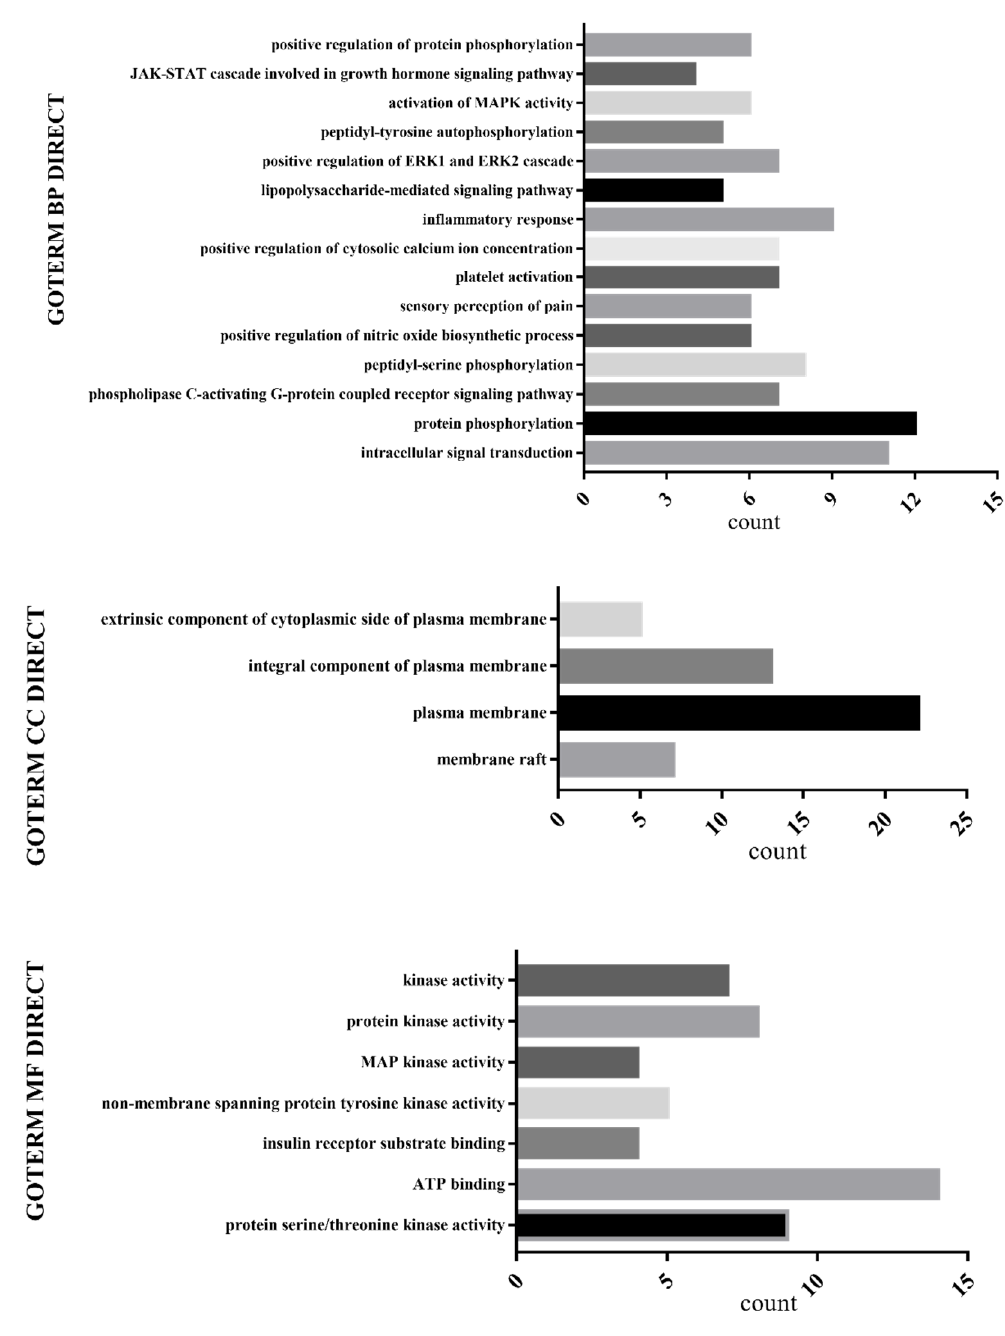
Figure 7. GO biological process enrichment analysis.